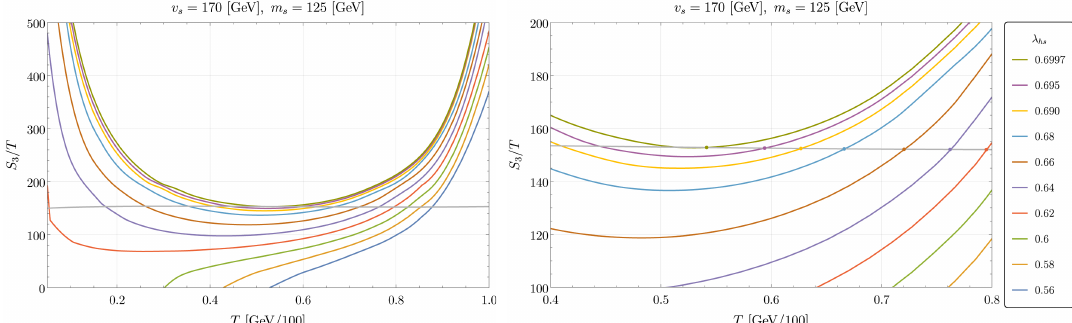
Figure 2 . Left : S 3 /T function with v s = 170 GeV and m s = 125 GeV. We observe that the nucle- ation temperature saturates around T nuc ≈ 54 GeV. The horizontal gray line satisfy the nucleation condition S 3 /T nuc = 3 log ( S 3 / 2 πT nuc ) + 4 log ( T nuc /H ) . Right : zooming in on the region with 2 lower nucleation